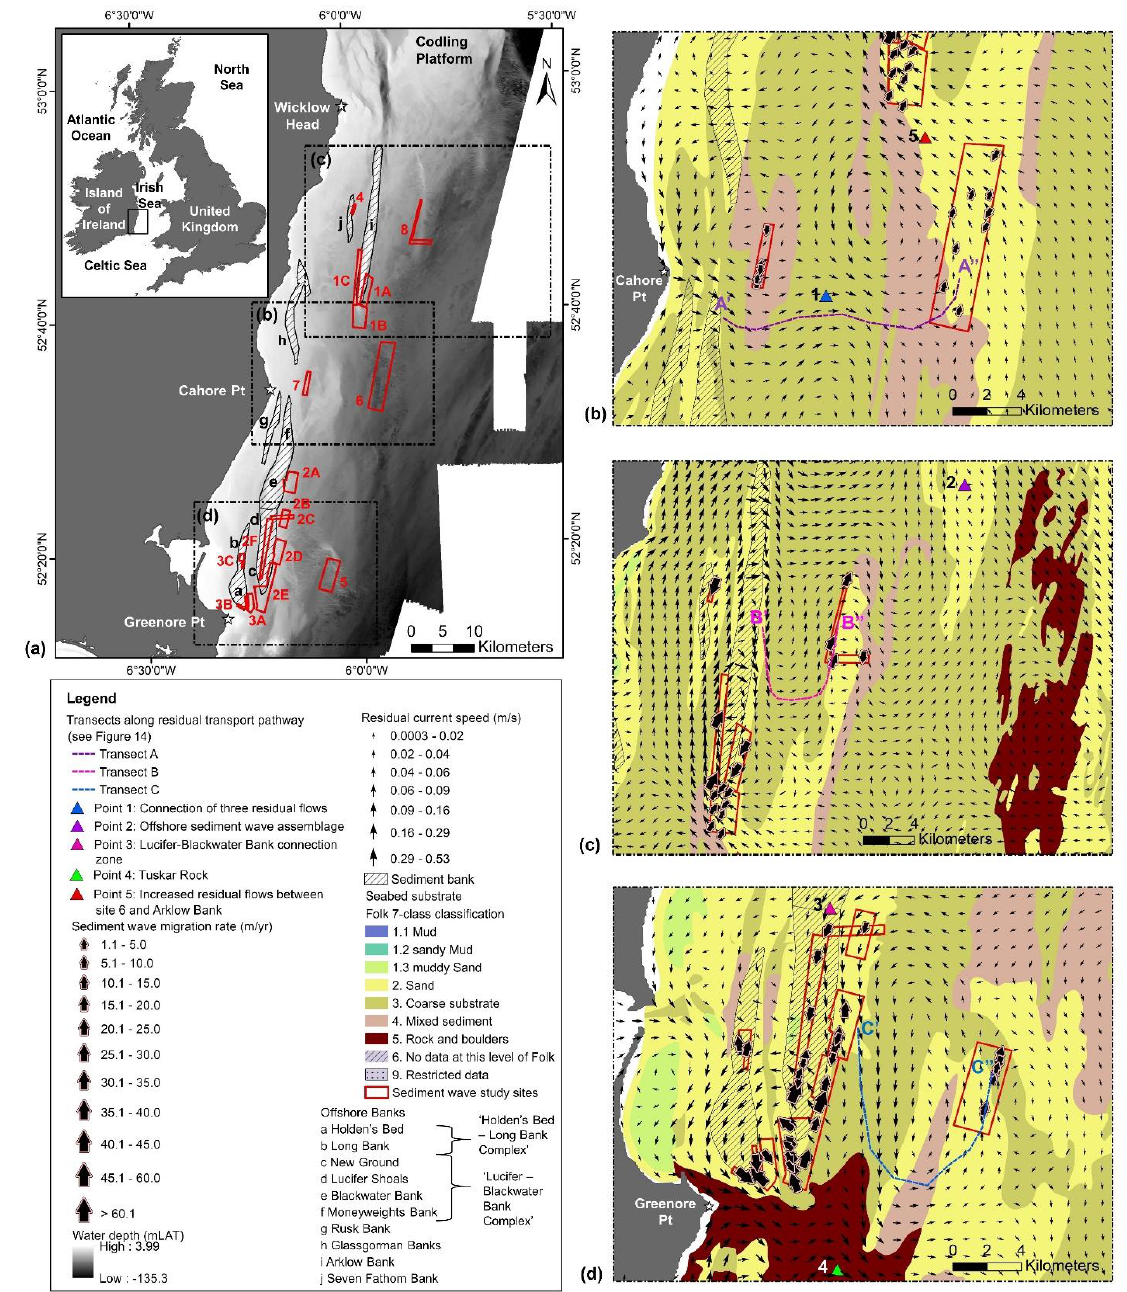
Figure 13. Overview of three residual circulatory transport systems in the south-western Irish Sea connecting offshore sediment banks with independent offshore sediment wave assemblages: ( a ) Location of three circulatory systems, main offshore sediment banks mentioned in the text and areas of analysed sediment waves by this study, ( b ) circulatory system (i) outlined in the text (5.1.2), connecting assemblages at site 6 and site 7 with Lucifer–Blackwater Bank complex and Arklow Bank, ( c ) circulatory system (ii) outlined in the text connecting sediment wave assemblage at site 8 and the further offshore assemblage at Point 2 with Arklow Bank, and ( d ) circulatory system (iii) outlined in the text, connecting the sediment wave assemblage at site 5 with the Lucifer–Blackwater Bank complex. Transects in A, B, and C are presented in Figure 14. Bathymetry source: composite map produced from INFOMAR datasets (https://www.infomar.ie/data [Accessed: 10 June 2021]) (see Section 3.1). Seabed substrate source: EMODnet Seabed Habitats initiative ( http://www.emodnet-seabedhabitats.eu/ [Accessed: 25 June 2021])